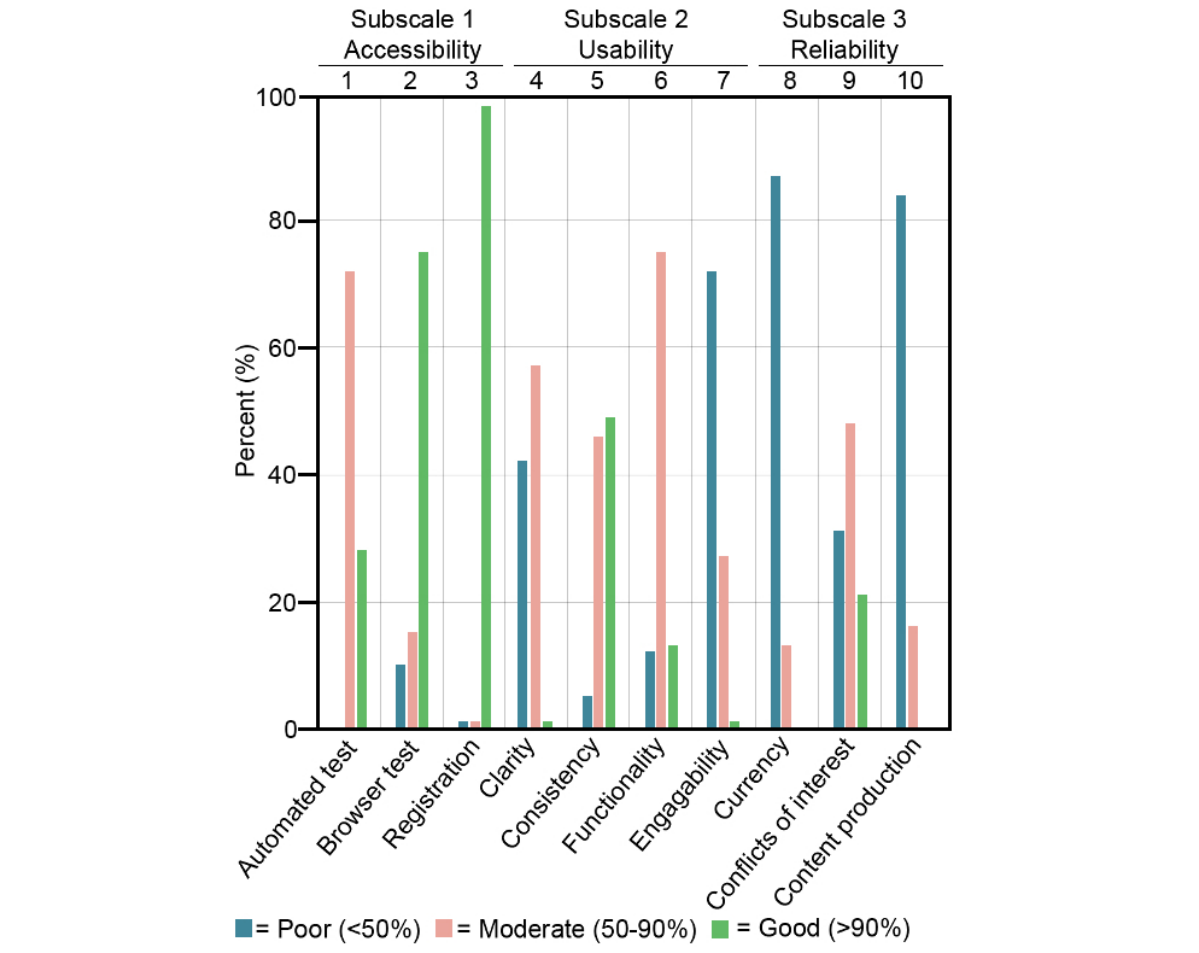
Figure 3. Proportion of websites (N=67) categorized into three categories from poor to good, for the subscales and total LIDA